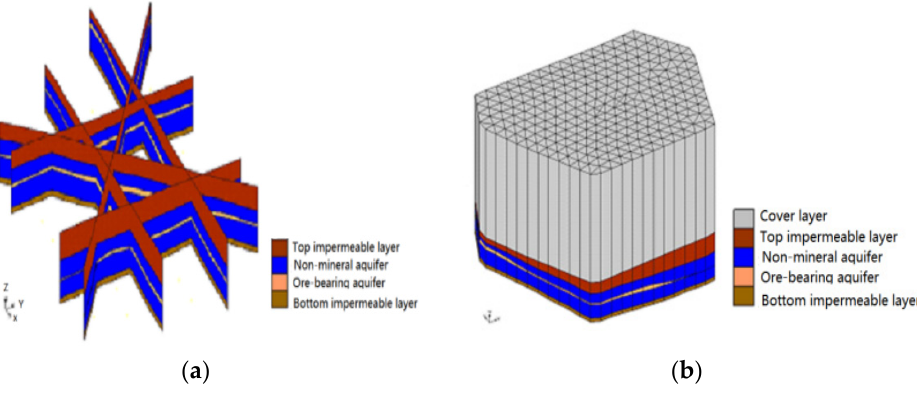
Figure 1. Mining area model constructed by GMS. ( a ) Three-dimensional geological profile of the mining area; ( b ) Three-dimensional stratigraphic map of the mining area.